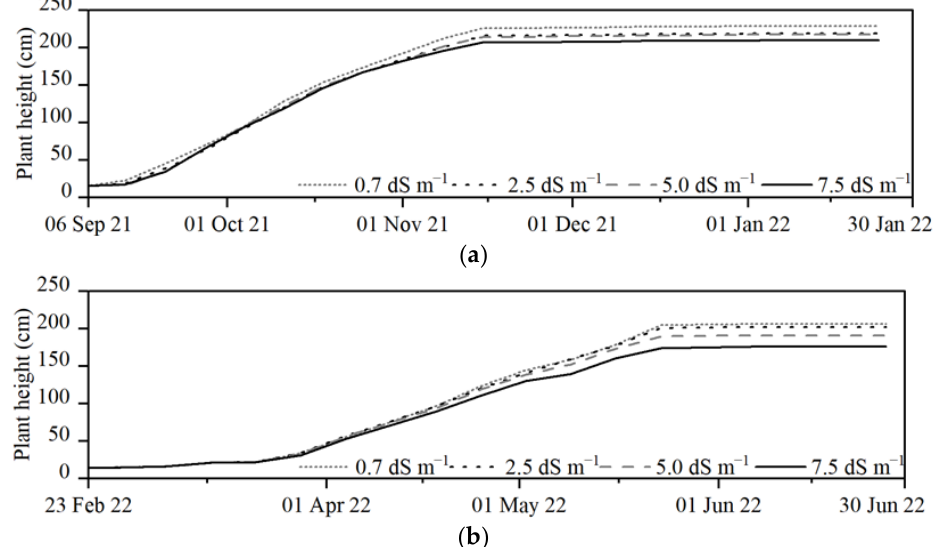
Figure 4. Changes in plant heights under different water salinity levels throughout the growing seasons; ( a ) autumn 2021 and ( b ) spring 2020.